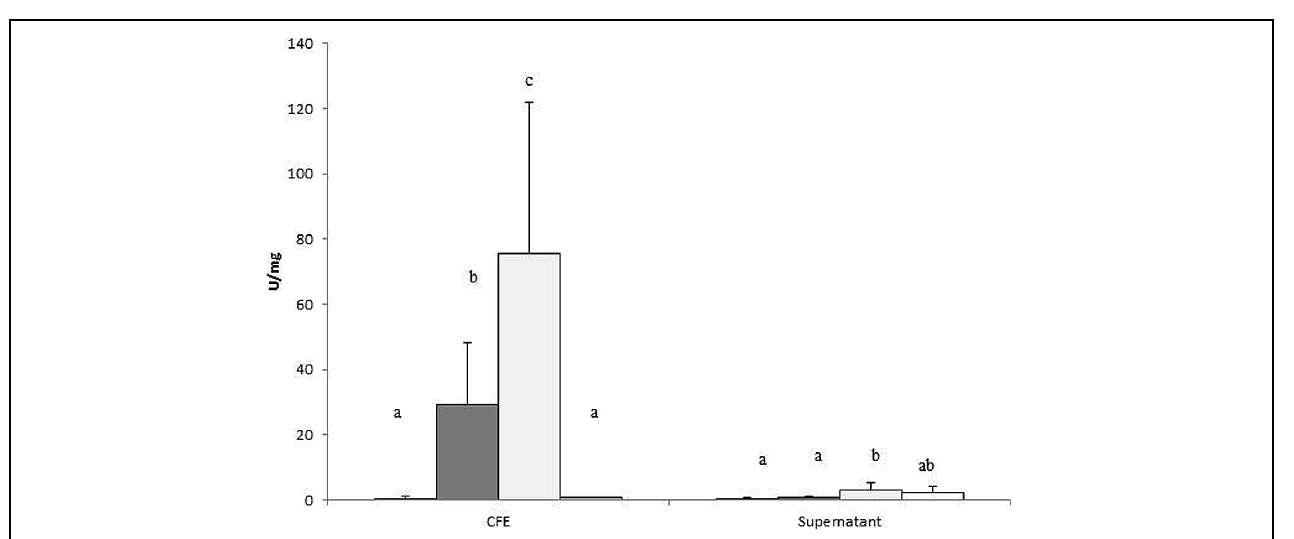
FIGURE 2 | α -glucosidase activity was determined in cell-free extract (CFE) and supernatants of B. fragilis grown in glucose (black bars), EPS E44 (dark gray bars), EPS R1 (light gray bars) and without carbon source added (WCS; white bars), and was referred